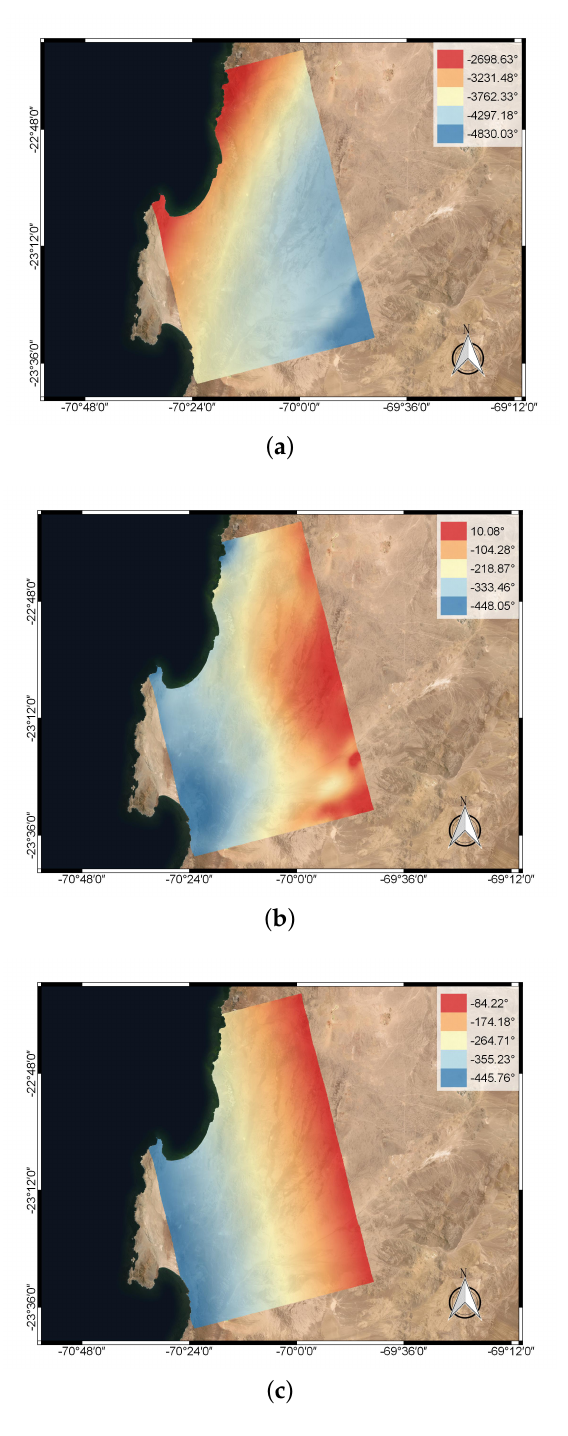
Figure 10. Ionospheric correction with Doppler frequency error by SSM on 20080131 and 20080317: ( a ) Ionospheric phase delay. ( b ) Corrected DInSAR phase. ( c ) Corrected DInSAR phase difference. The baseline of two sensors is determined by the orbit vectors of SLCs. The error in orbit vectors results in baseline error, and then baseline error influences the ionospheric correction. We add an error around 0.20 m to the baseline of the interferogram on 20080131 and 20080317 and use SSM to